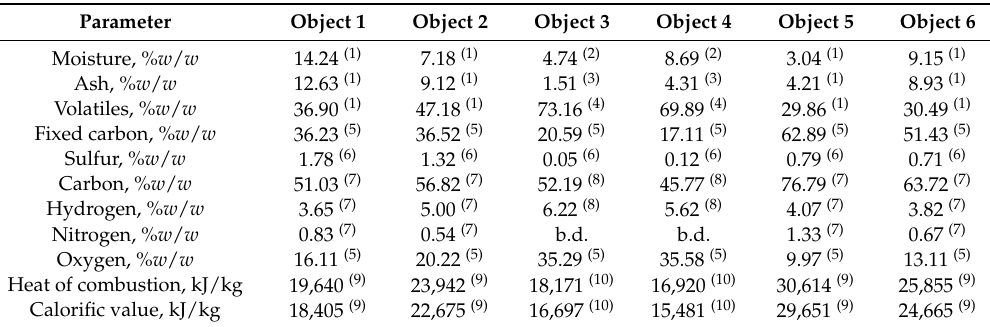
Table 1. Chemical and physical parameters of fuel